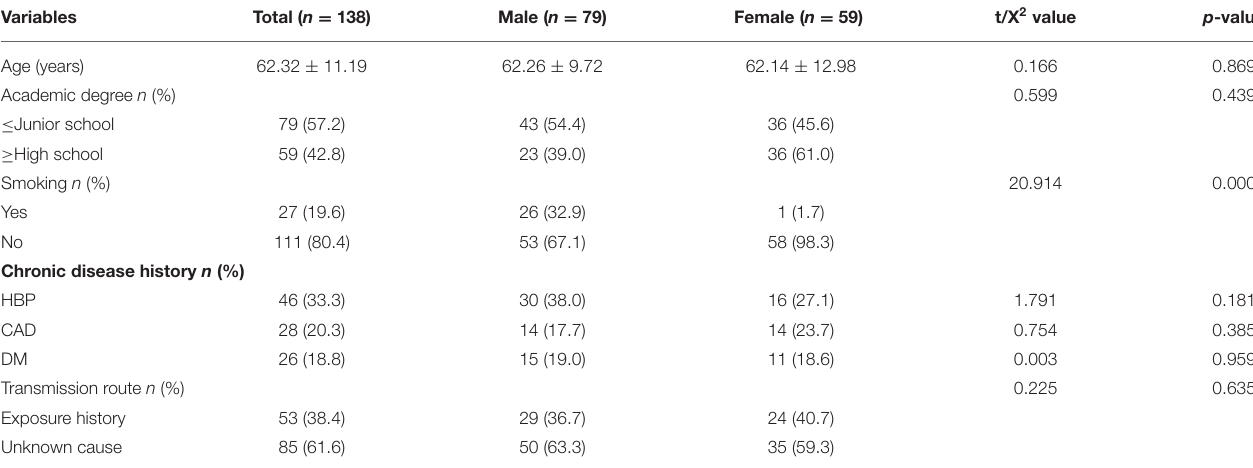
TABLE 1 | Gender differences in general characteristics of 2019-nCoV infection.